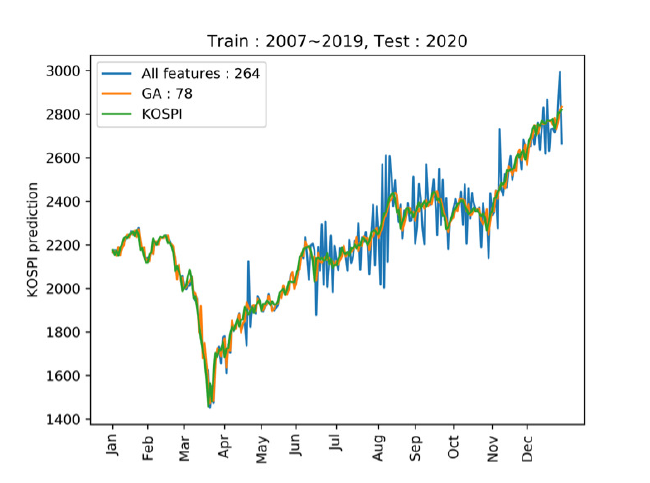
Figure 8. Prediction of KOSPI after COVID-19. Table 4. Prediction of the direction of KOSPI. Results without feature selection (left) and with the genetic wrapper